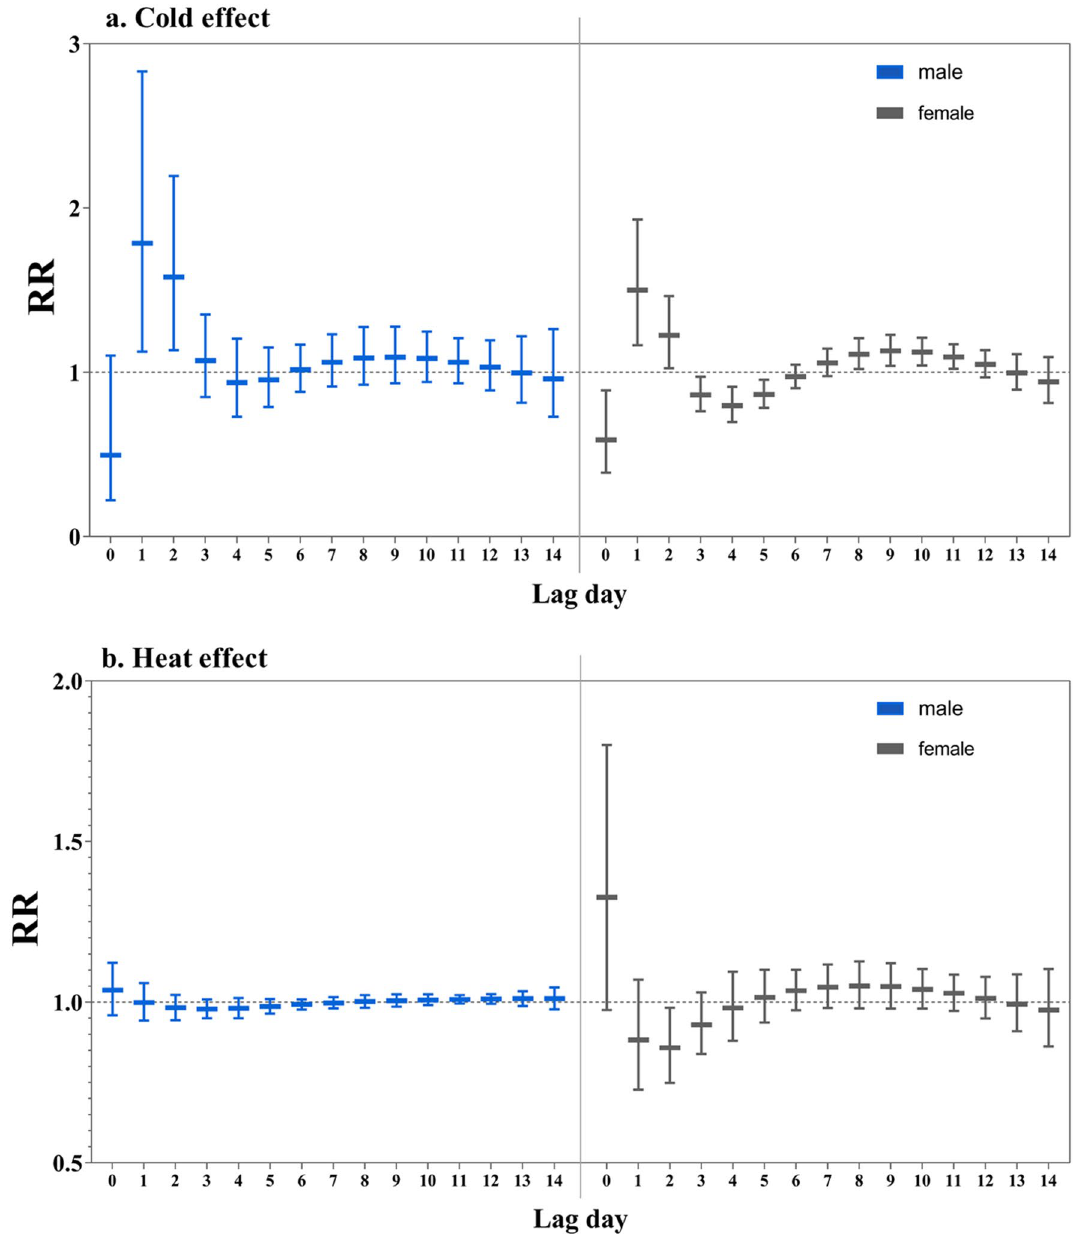
Figure 5. The single day effects of extreme apparent temperature for admissions due to acute cardiac events cross different lag day(s) in gender-specific groups, with the reference of the Minimum Admission Apparent Temperature (MAAT) of each group. Notes: MAAT for male and female group was 33 °C and 22 °C,